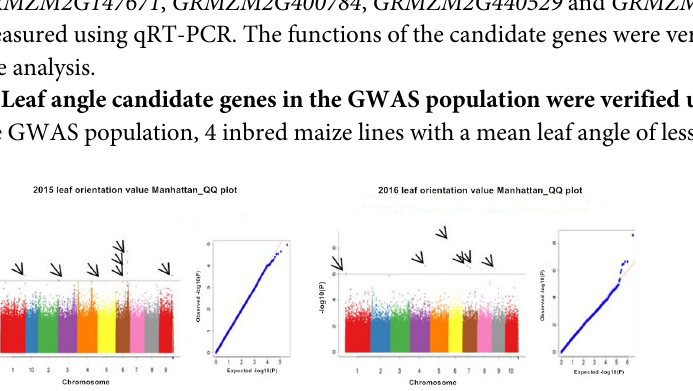
Fig 5. Leaf orientation value Manhattan plot and QQ plot for the two